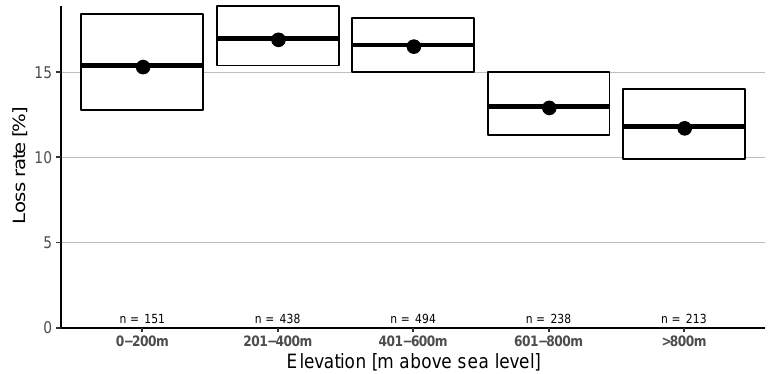
Figure 3. Winter honey bee colony loss rates (and 95% CI) grouped into five different elevation above sea level